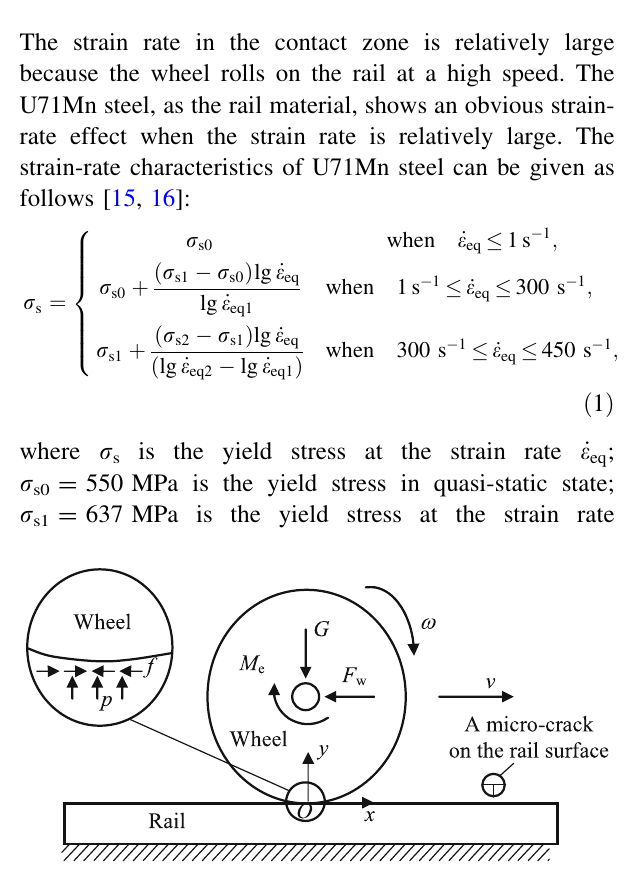
Fig. 1 Model for wheel/rail in rolling contact Fig. 2 Quarter-points elements at the crack